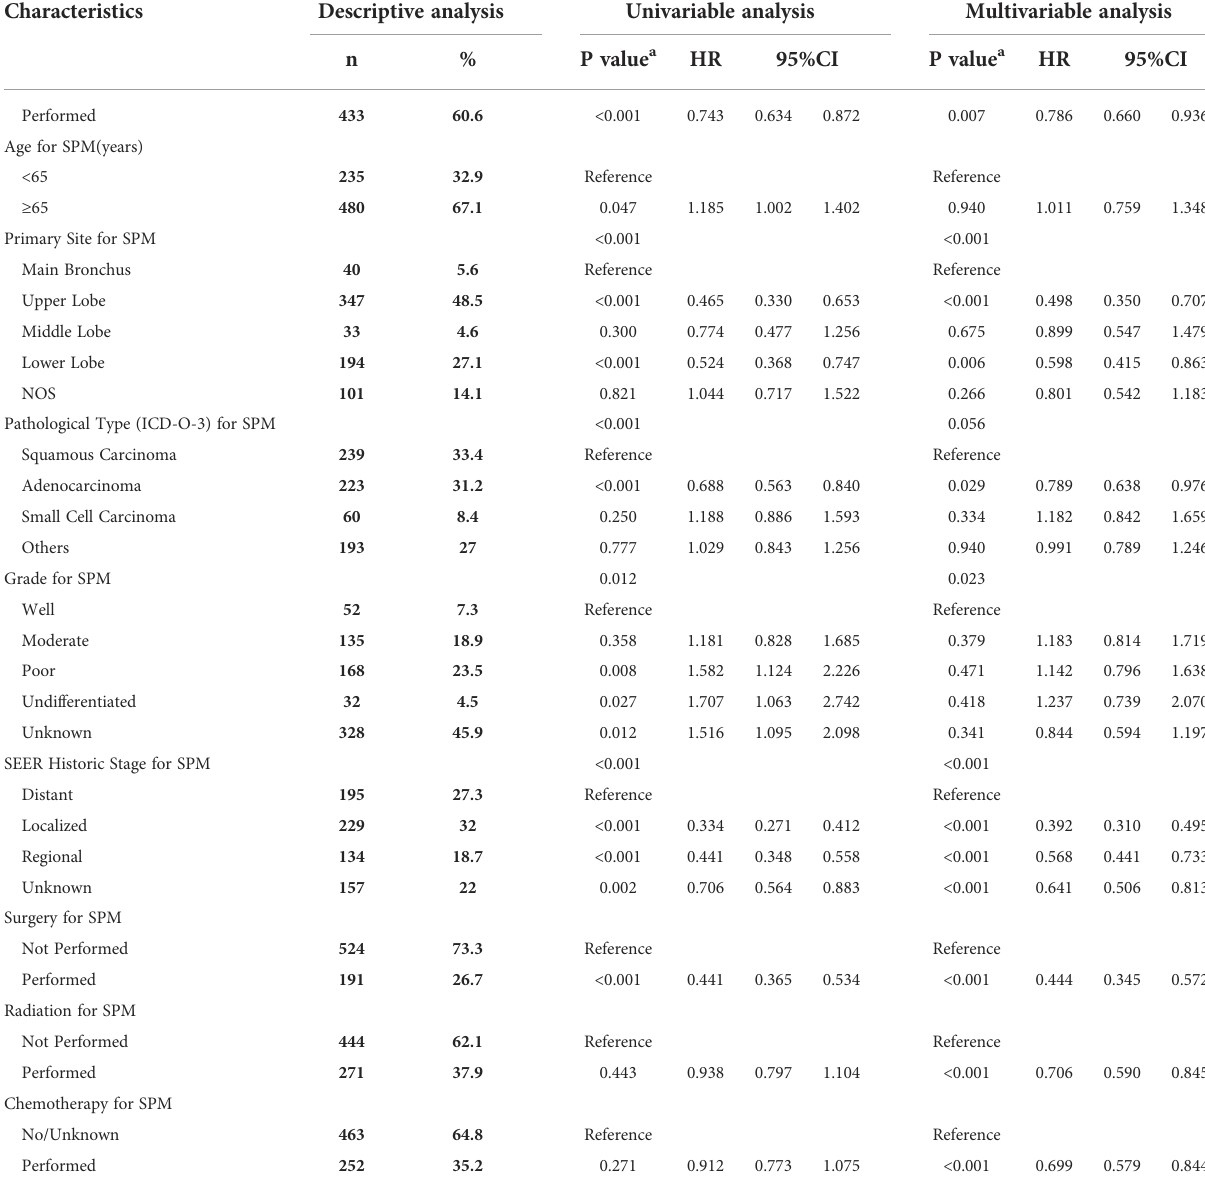
patients with SPLC-EC (Figures 3A, B). We set lung cancer- speci fi c mortality as the fi nal event and esophageal cancer- speci fi c mortality as the competitive event. The Fine – Gray proportional sub-distribution risk model indicated that surgery for SPM was an independent risk determinant for lung cancer- speci fi c mortality in SPLC-EC patients (P=0.016, HR=0.457, 95% CI 0.325 – 0.642). Surgery for FPM was an independent risk factor for esophageal cancer-speci fi c mortality (P=0.016, HR=0.532, 95% CI 0.397 – 0.713).